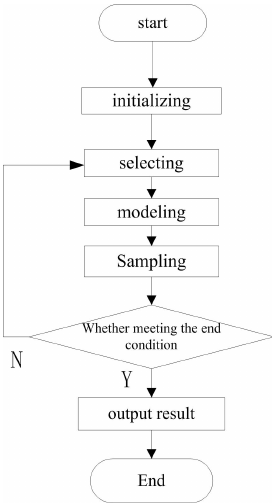
Figure 1. The flow chart of